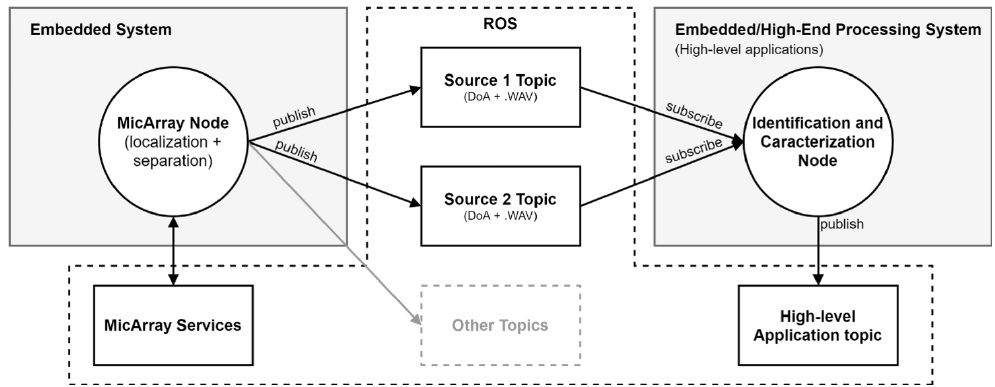
Figure 2. ROS architecture/interface between the sound source localization and separation system and the characterization